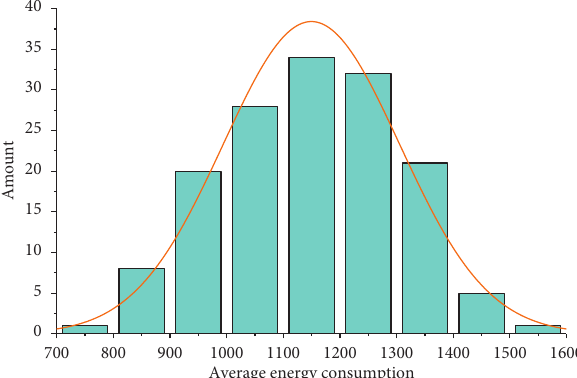
Figure 4: Statistics on average energy